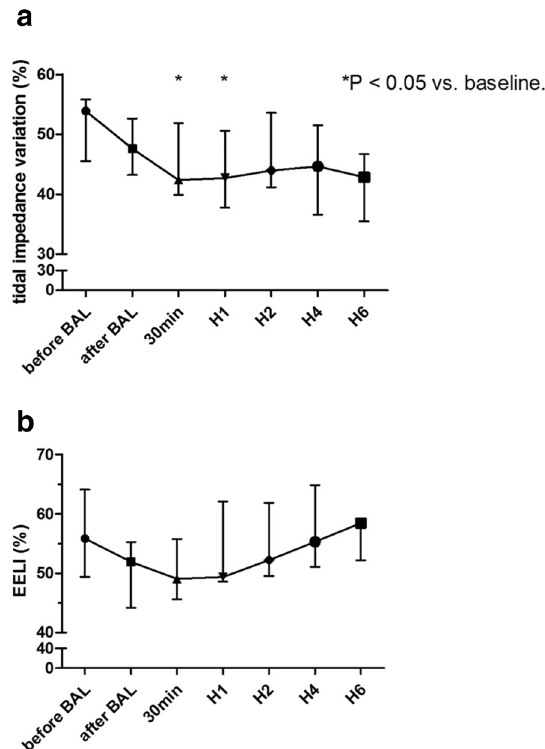
Fig. 1 Distribution of A) median tidal impedance variation and B) median End‑Expiratory Lung Impedance, in the side of broncho‑alveolar lavage on patients without Acute Respiratory Distress